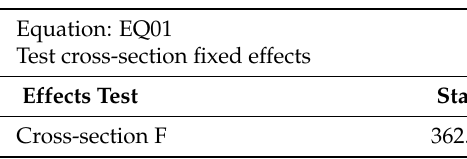
Figure 6. The normality tests. Table 4. Redundant Fixed Effects Tests.